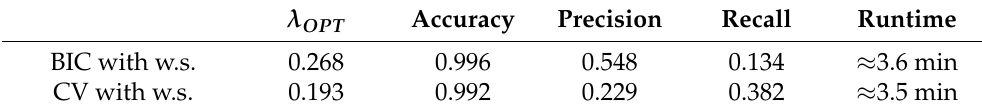
Figure 6. Left panel: values of BIC obtained with warm start for jewel . Right panel: CV error obtained with warm start. Results are reported for one randomly chosen realization with K = 3, p = 500, n k = 100, m = 1, power = 1. Red circles denote the estimated optimal λ OPT . Table 2. Results of BIC and CV procedures with and without warm start for jewel in the case K = 3, p = 500, n k = 100, m = 1, power = 1. Performance metrics and runtime were evaluated with estimated λ OPT